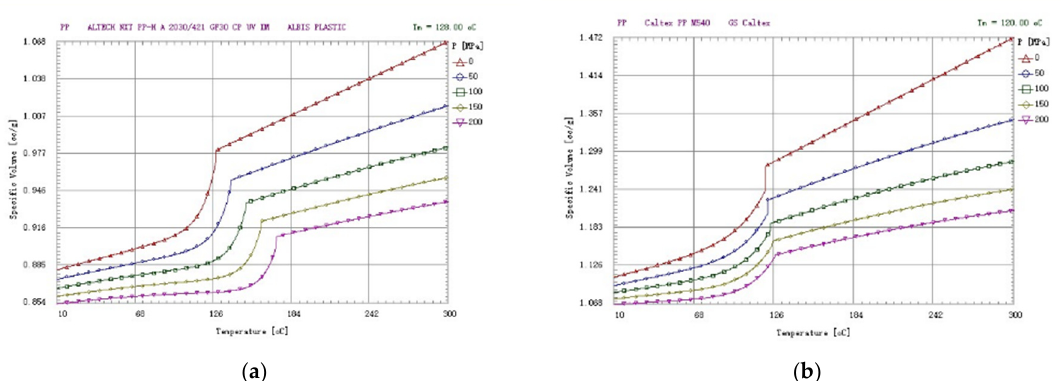
Figure 2. The PvT chart with PP material and different Glass Fiber.